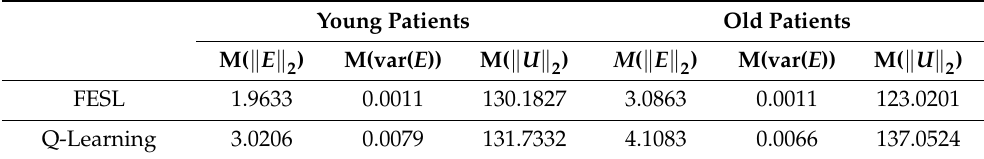
Table 3. Result of simulations. Young Patients Old